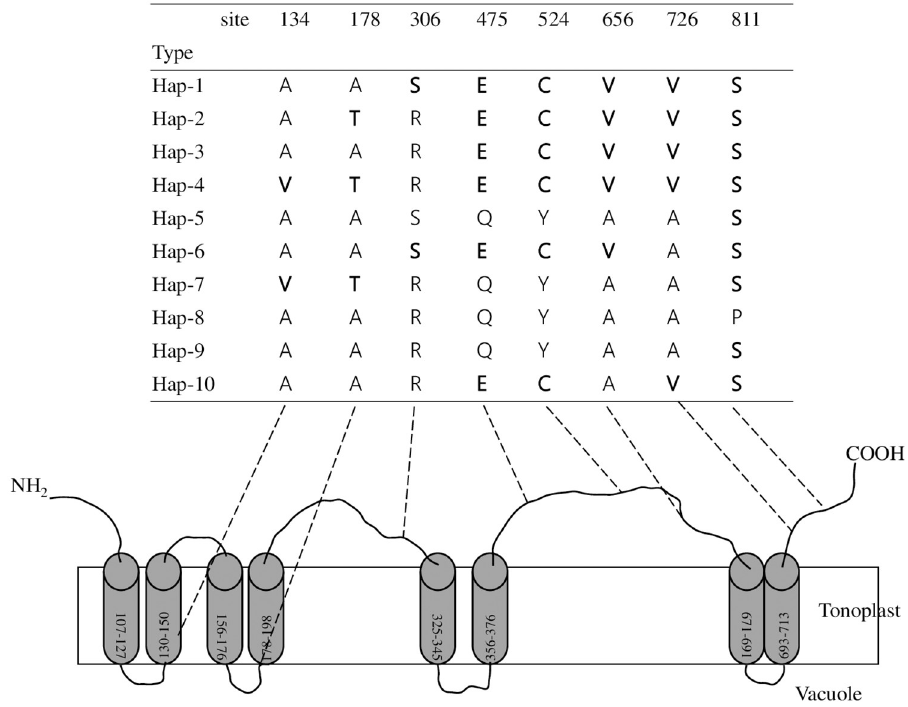
Fig 2. Polypeptide sequences of HMA3-D1 in the 80 accessions of Ae . tauschii . Polymorphisms generating a changed peptide are indicated in bold compared with Hap-8 (TaHMA3-D1). Transmembrane domains were predicted by